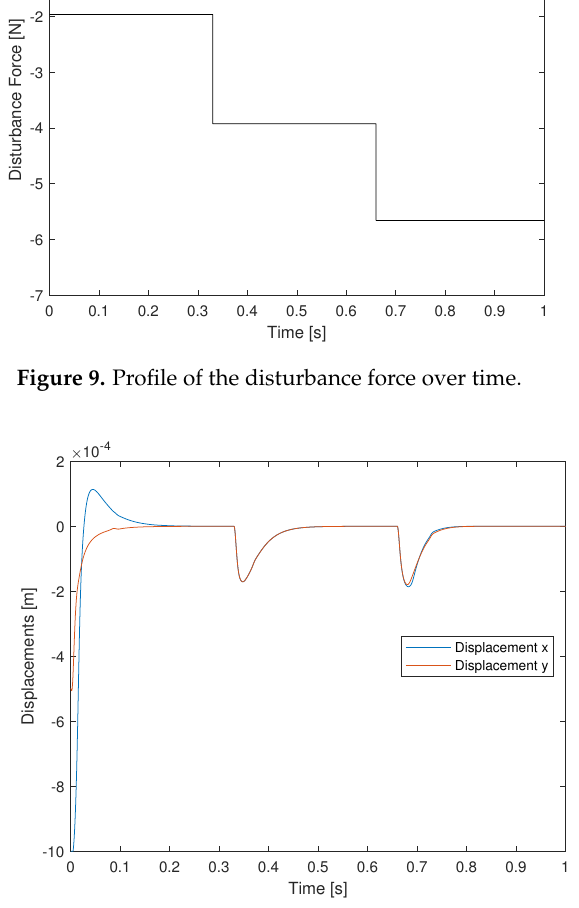
Figure 10. Displacements with the star connection.